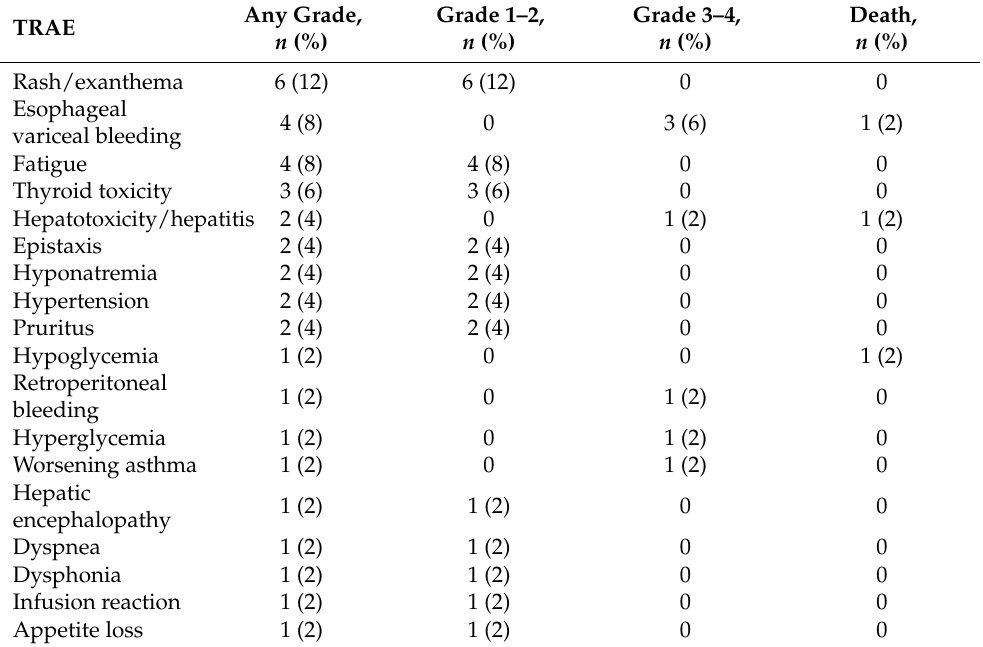
Table 3. Treatment-related adverse events (TRAE) during the treatment in the safety population. Any Grade, Grade 1–2, Grade 3–4, Death, TRAE n (%) n (%) n (%) n (%) Rash/exanthema 6 (12) 6 (12) 0 0 Esophageal 4 (8) 0 3 (6) 1 (2) variceal bleeding Fatigue 4 (8) 4 (8) 0 0 Thyroid toxicity 3 (6) 3 (6) 0 0 Hepatotoxicity/hepatitis 2 (4) 0 1 (2) Epistaxis 2 (4) 2 (4) 0 Hyponatremia 2 (4) 2 (4) 0 Hypertension 2 (4) 2 (4) 2